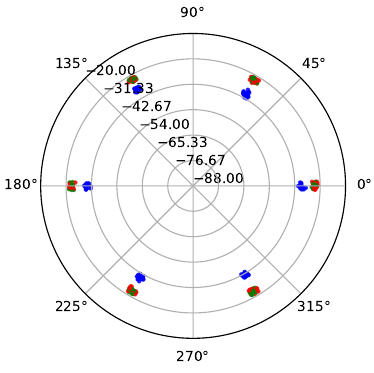
Figure 9. Directionality of ESP32 with the external 6 dBi omnidirectional antenna. RSS measurements in dBm unit collected at different angular positions are plotted in different colors with red for channel 37, green for channel 38, and blue for channel 39. Transmitter and receiver devices are 1 m apart in distance.